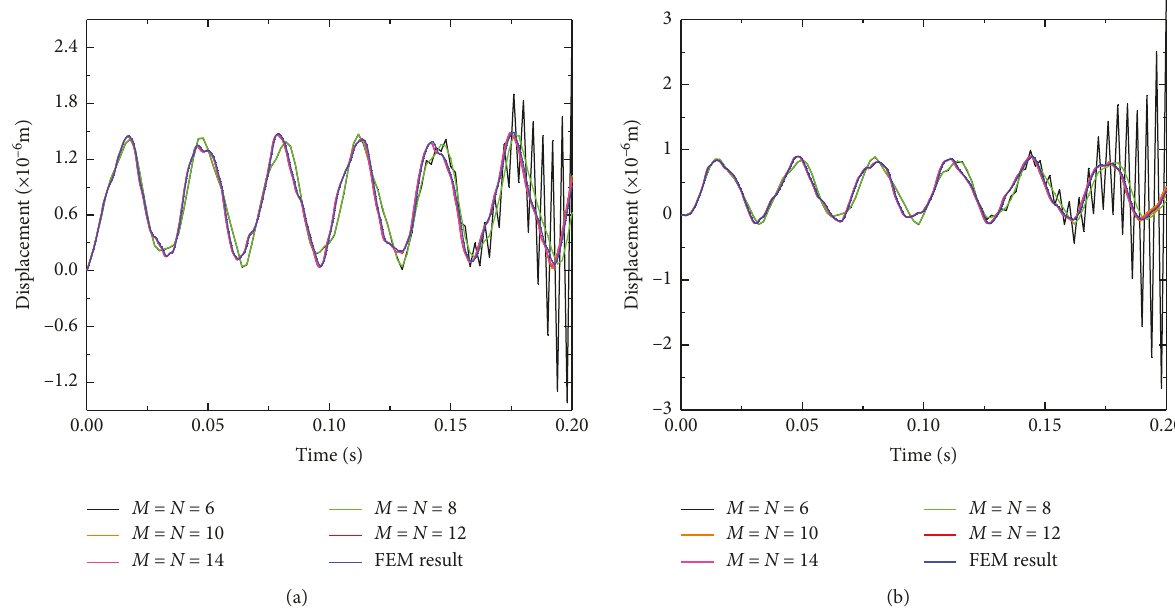
Figure 13: Convergence of transient responses for rectangular plate with one central x -wise beam and one central y -wise beam under unit force ( q w � 1). (a) Point A (1 m, 0.5m). (b) Point B (0.5m,